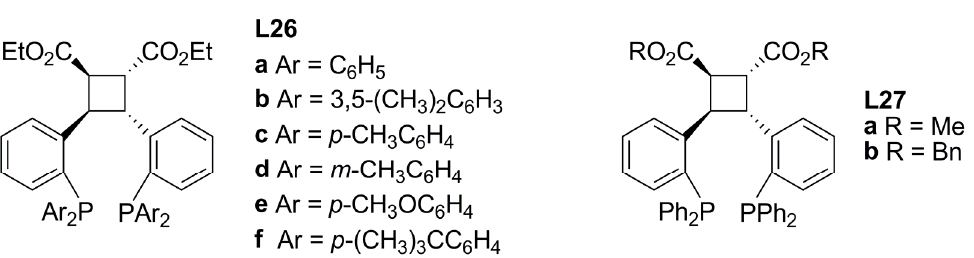
Figure 11. Diphosphines containing a cyclobutene